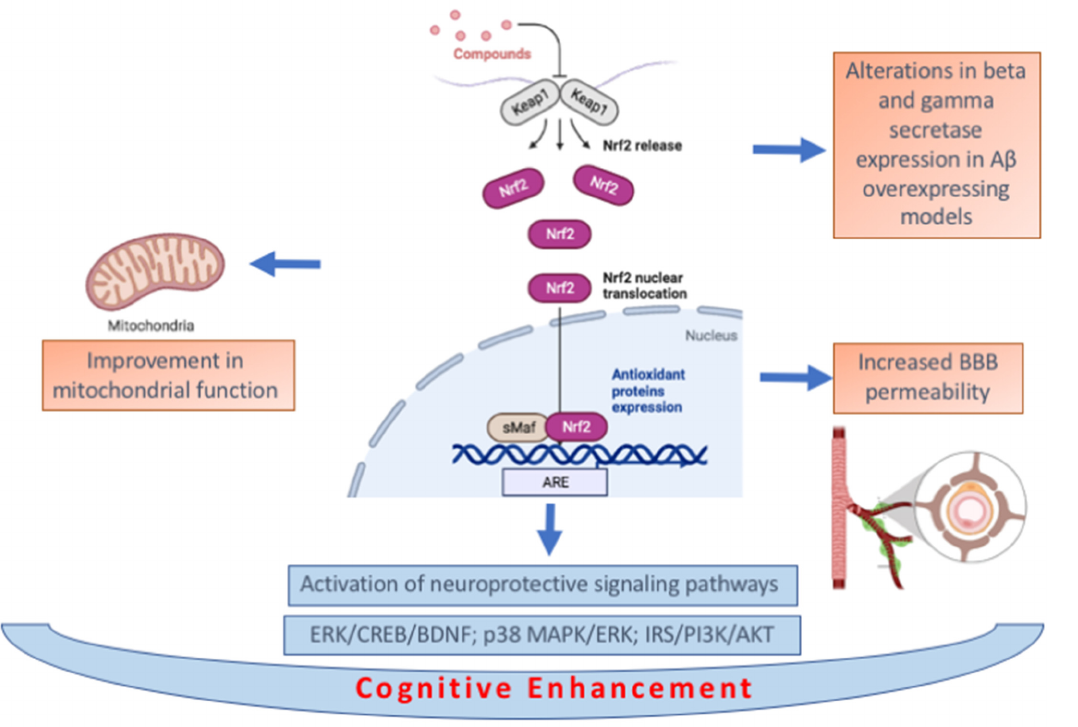
Figure 4. Summary of biochemical pathways associated with cognitive. enhancement by NRF2 activating compounds (created in BioRender.com, accessed on 20 July